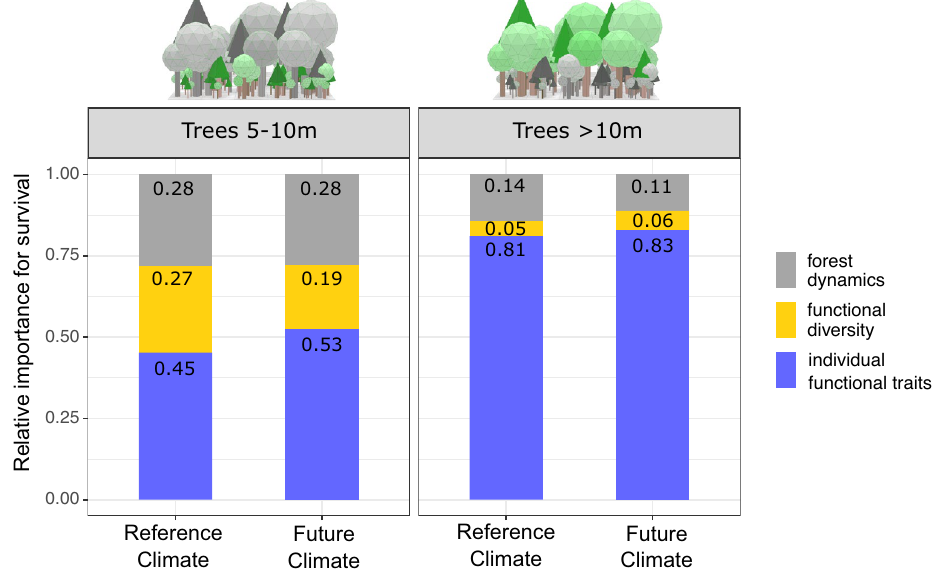
Figure 5. Variables importance for small and large trees. Normalized variable importance for forest dynamics (grey), functional diversity (yellow) and individual functional traits (blue) averaged across all forest types under reference climate (left bars) and future climate (RCP 4.5, right bars) for small trees (5–10 m) in left panel) and large trees (> 10 m) in right panel, respectively. Functional diversity and forest dynamics are more important for small trees compared to large trees, whereas individual functional traits matter most for large trees. This pattern was found to be consistent across all sites (see Supplementary Table